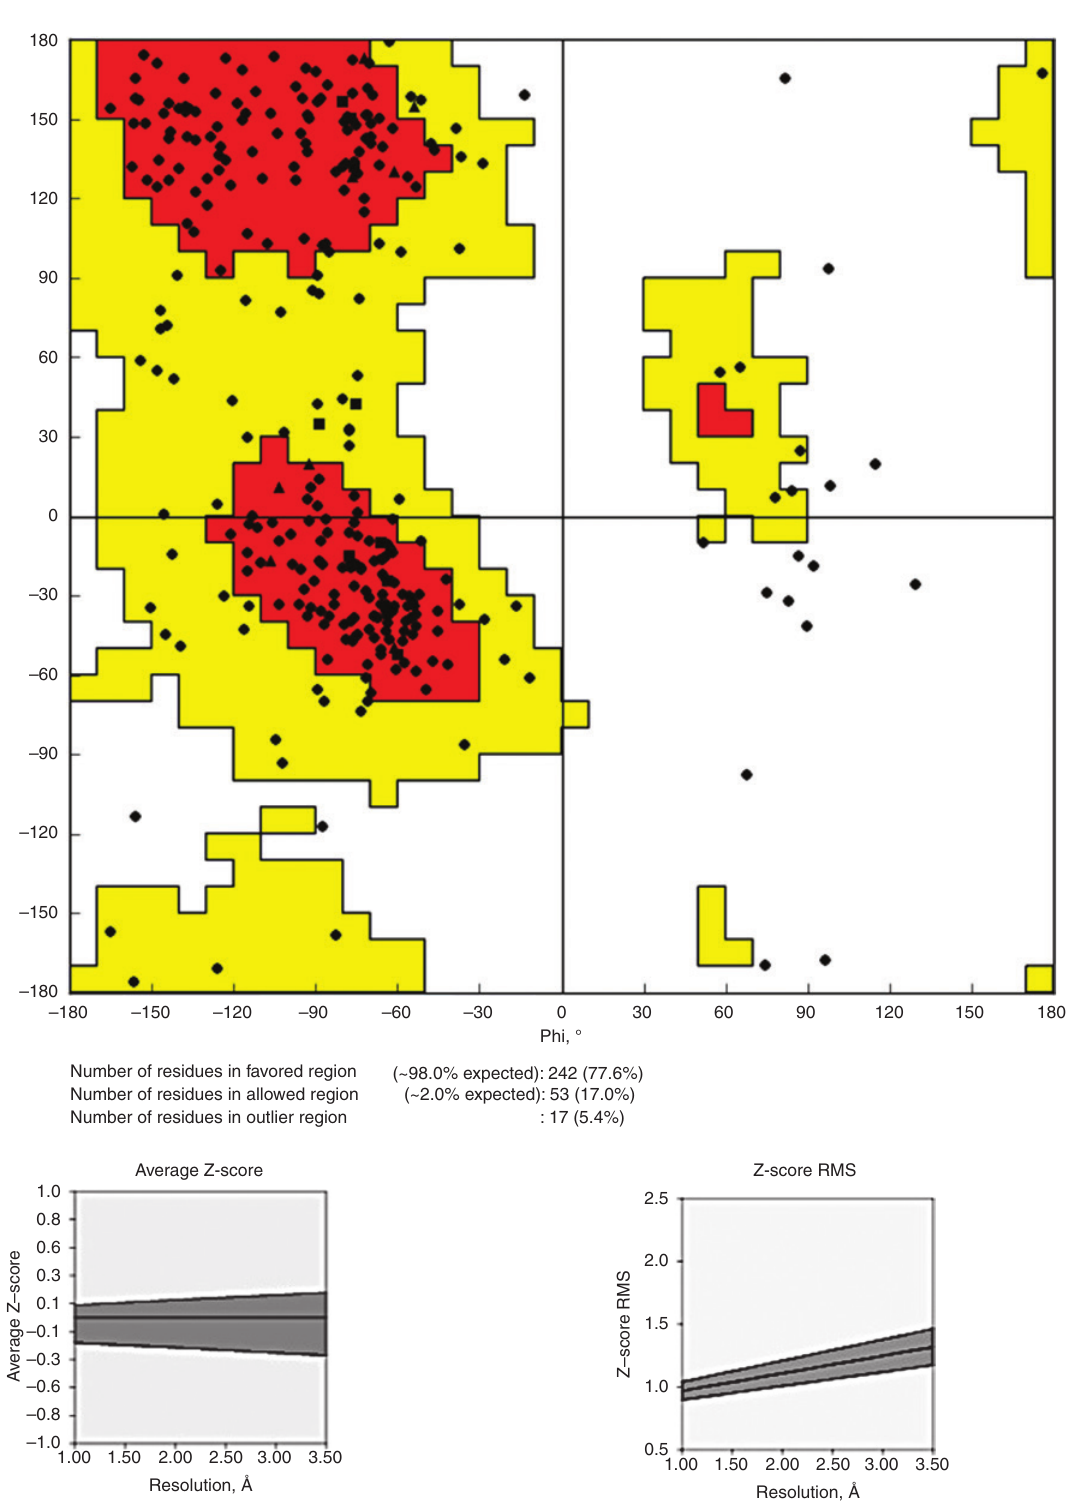
Figure 9: Plotting modeled amino acids conformations for stereo chemical quality and protein moiety check with Z-score